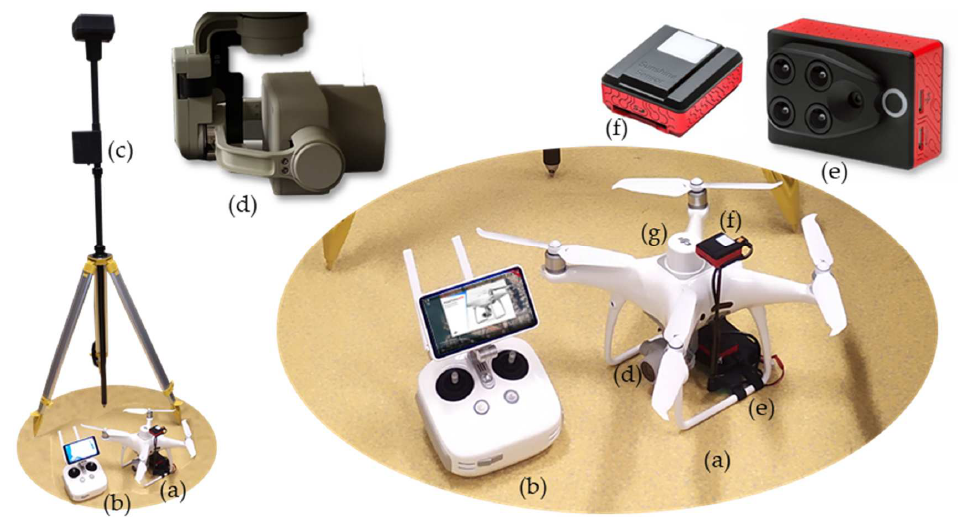
Figure 2. Dji Phantom 4 RTK: ( a ) UAV; ( b ) remote controller; ( c ) D-RTK2 base station; ( d ) RGB camera on the motorized gimbal; ( e ) SEQUOIA multispectral camera; ( f ) light sensor; ( g ) GNSS antenna.